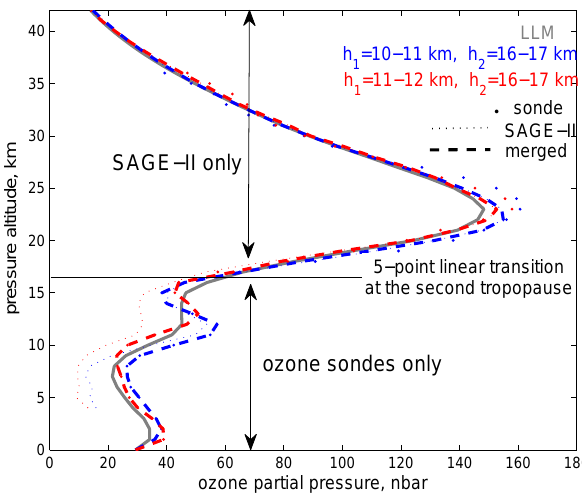
Fig. 7. Ozonesonde profiles, SAGE-II profiles and the merged ozone profiles for double tropopauses in February at latitudes 30 ◦ –40 ◦ N. Red and blue lines correspond to different double- tropopause heights. Dotted lines: SAGE-II climatological profiles, dots: ozonesonde profiles, dashed lines: merged TpO 3 climatologi- cal profiles. The LLM climatological profile (grey solid line) is pre- sented for